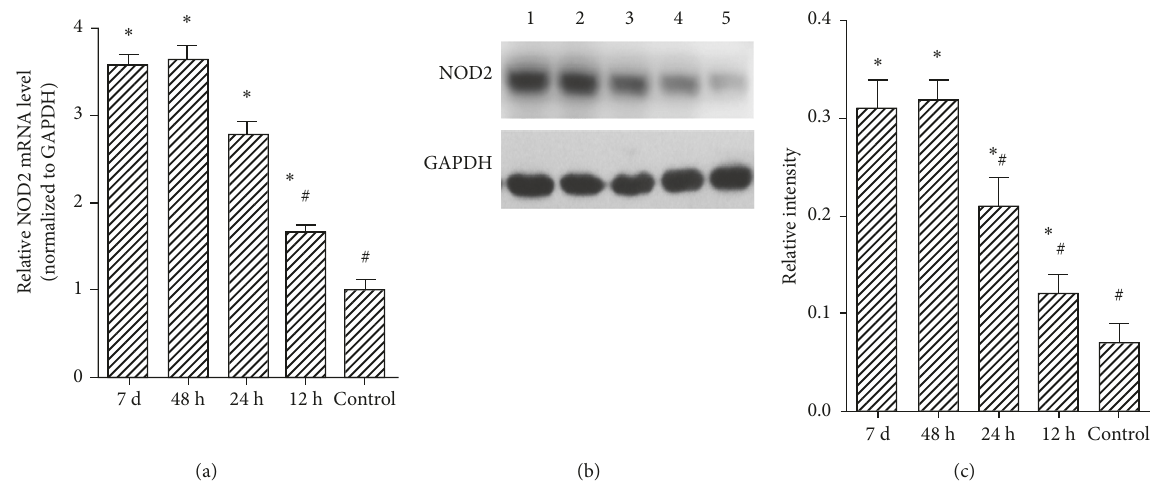
Figure 2: The NOD2 level analyzed by quantitative real-time polymerase chain reaction (qRT-PCR) and Western blot. (a) NOD2 level assessment based on qRT-PCR. (b) The expression level of NOD2 in different groups measured via Western blot analysis. (c) Quantitative analysis of the relative intensity of NOD2